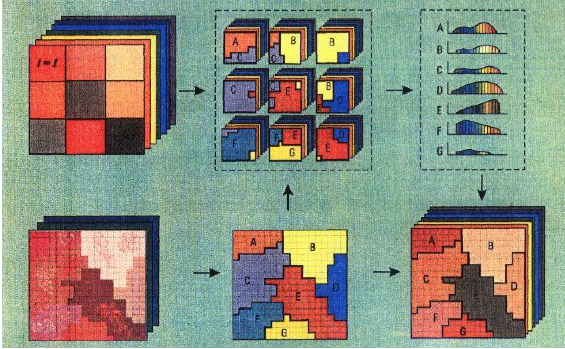
Figure 3. Principal processing scheme of the Multi-sensor Multi-resolution Technique (MMT) (from Zhukov et al.,